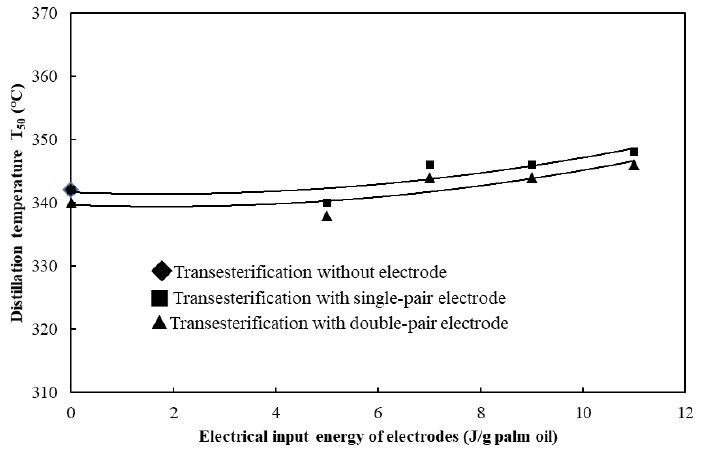
Figure 11. Effects of electrical energy input for dissociating water on 50 vol.% distillation temperature of biodiesel product.